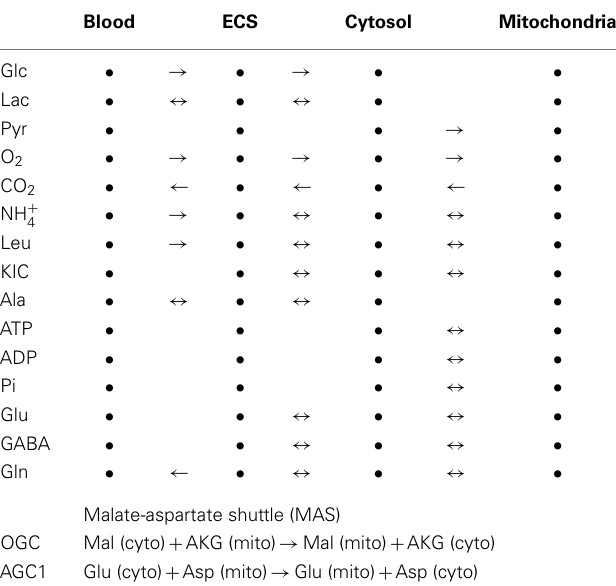
Table 2 |The transports implemented in the model.